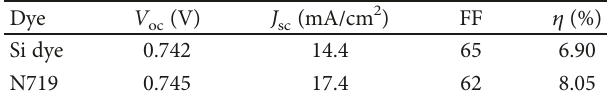
Table 3: Photovoltaic parameters of DSSC cells fabricated using CL-1 and N719 dyes recorded under simulated AM 1.5 sunlight at an intensity of 1 sun (1000W/m 2 ).